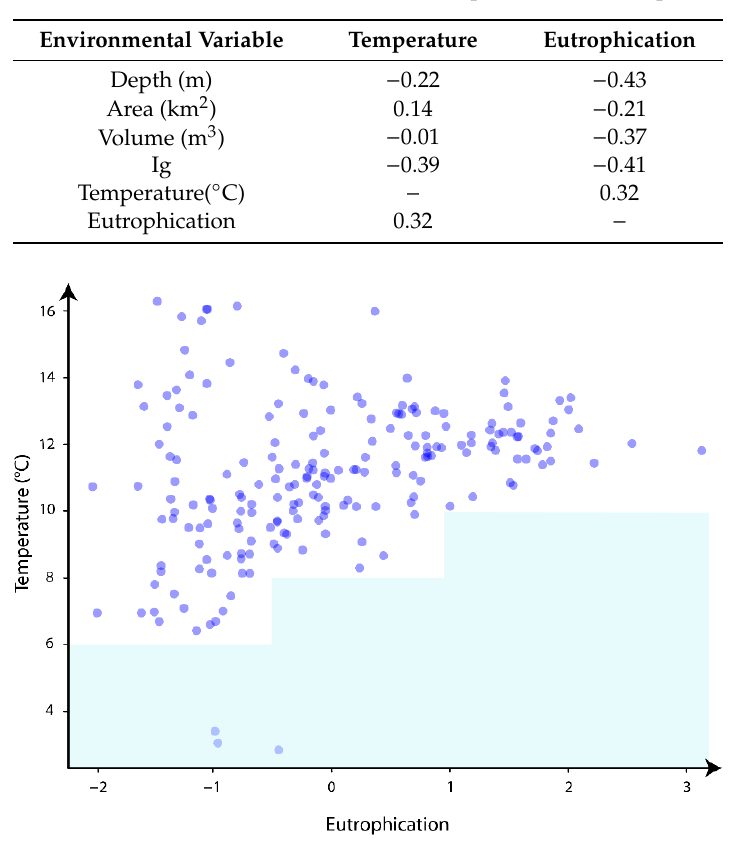
Figure 1. Relationship between temperature and eutrophication of lakes.